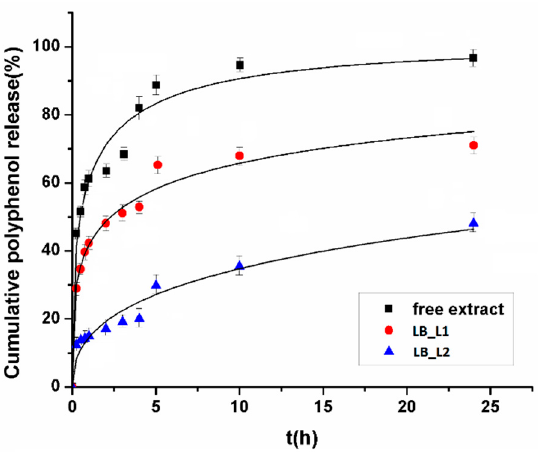
Figure 2. Polyphenols release from liposomes loaded with L. barbarum versus free L. barbarum fitted with Weibull function. LB_L1—liposomes loaded with L. barbarum; LB_L2—liposomes loaded with L. barbarum (formulation with sodium cholate).